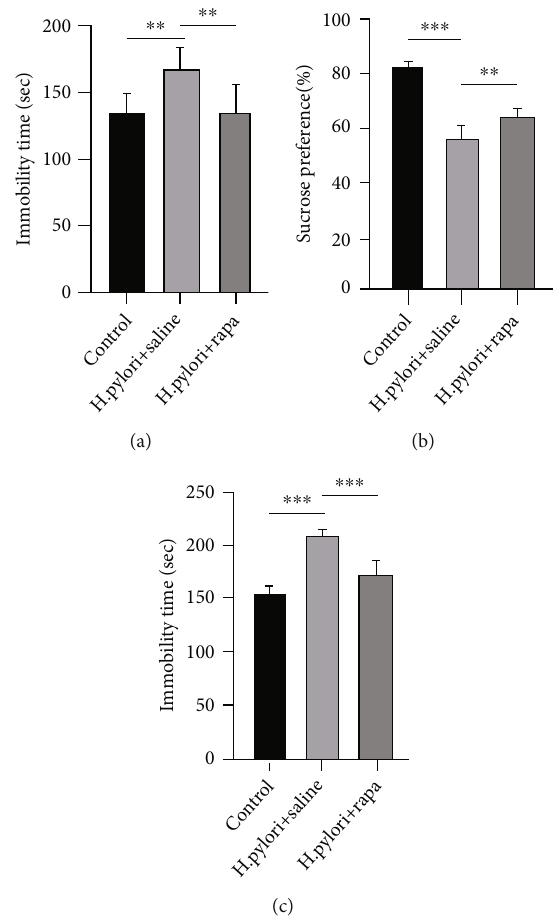
Figure 2: (a) FST, (b) SPT, and (c) TST of the control, H. pylori+saline, and H. pylori+rapa groups. ∗ P < 0 : 05, ∗∗ P < 0 : 01, and ∗∗∗ P < 0 : 001 versus respective